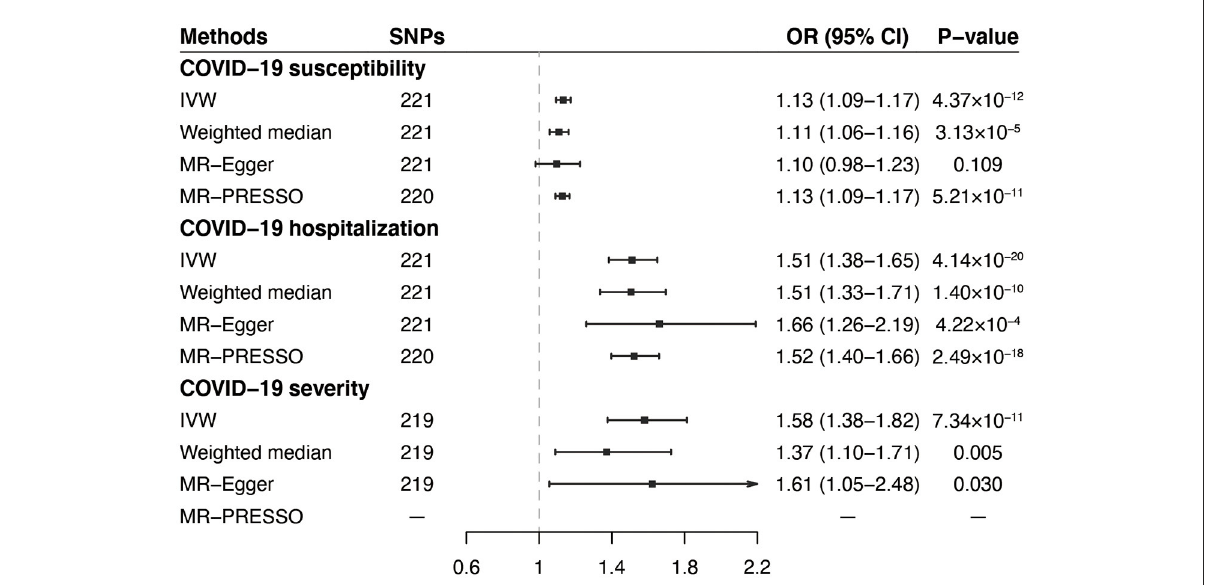
FIGURE2 Associations of genetically predicted VAT mass with COVID-19 outcomes in primary analyses. VAT, visceral adipose tissue; COVID-19, Coronavirus Disease 2019; SNPs, single nucleotide polymorphisms; OR, odds ratio; CI, confidence interval; IVW, inverse-variance weighted; MR-PRESSO, MR-pleiotropy residual sum and outlier.